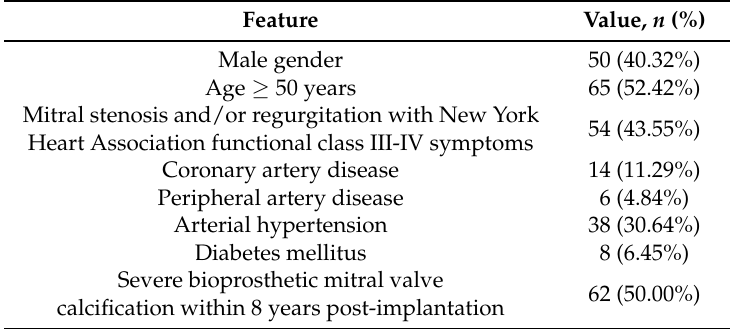
Table 3. Clinical features of the patients who underwent mitral valve replacement